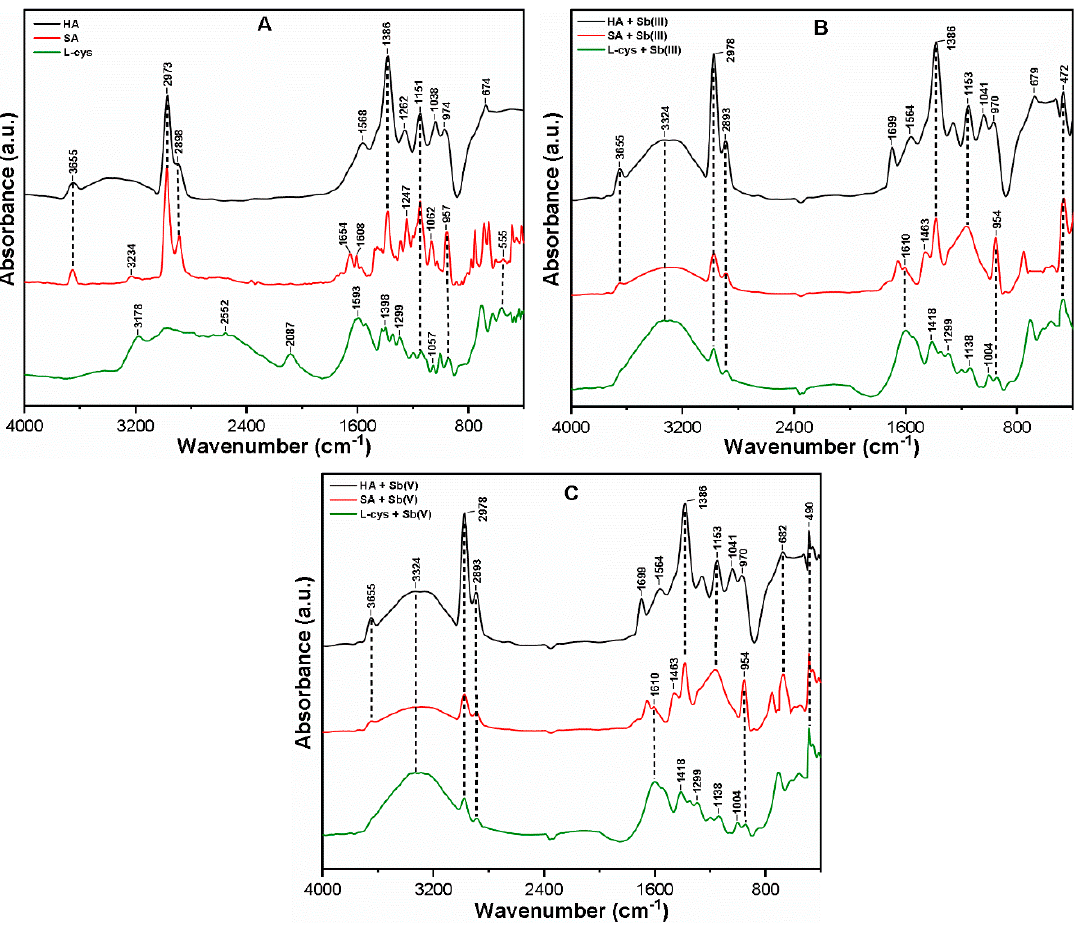
Figure 1. FT-IR analyses of ( A ) pristine HA, SA, and L-cys; ( B ) Sb(III)-NOM; and ( C ) Sb(V)-NOM complexes.